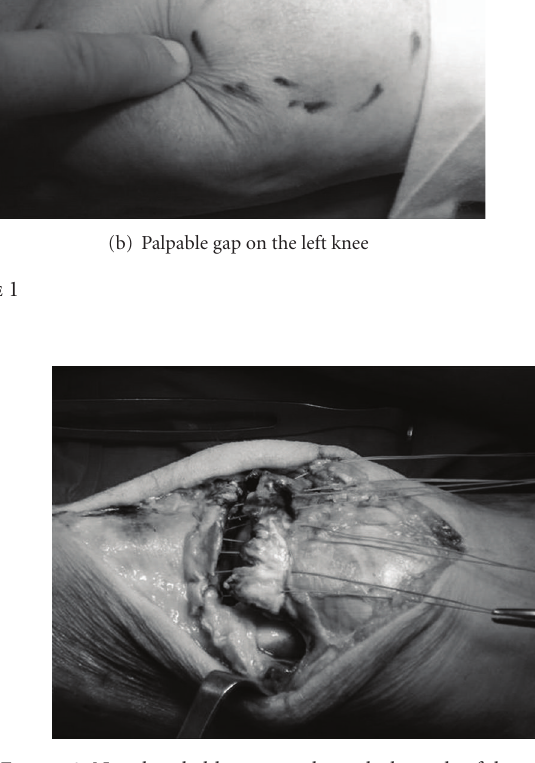
Figure 3: Nonabsorbable sutures through the ends of the ruptured patellar tendon in the left knee.